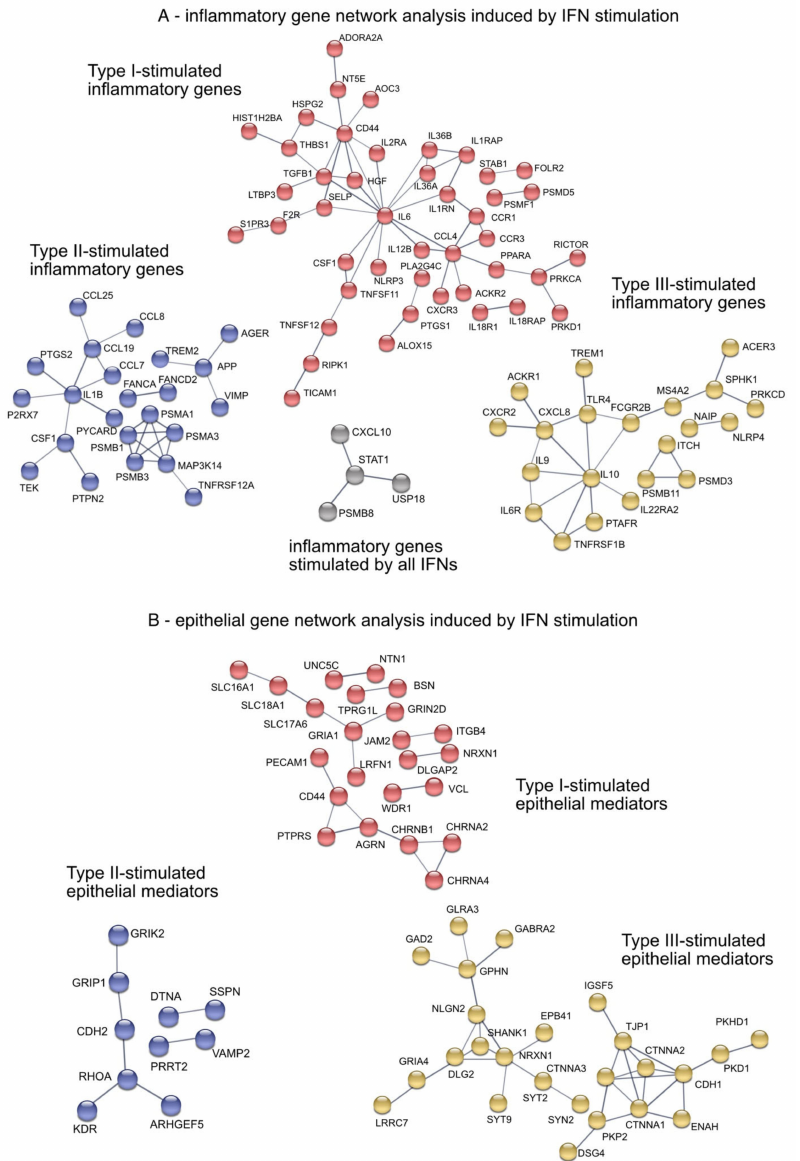
Figure 6. Gene network analysis of inflammatory pathways and epithelial mediators of IFN- stimulated differentiated organotypic 3D air-liquid interface cultures.( A ) Pro-inflammatory gene network analysis. Grey: overlapping induced inflammatory genes by type-I, -II and -III IFNs. Red: Type-I IFNs-induced inflammatory genes. Purple: Type-II IFN-induced inflammatory genes. Yellow: Type-III IFNs-induced inflammatory genes ( B ) Epithelial mediators gene network analysis. Red: Type-I IFNs-induced epithelial mediators. Purple: Type-II IFN-induced epithelial mediators. Yellow: Type-III IFNs-induced epithelial